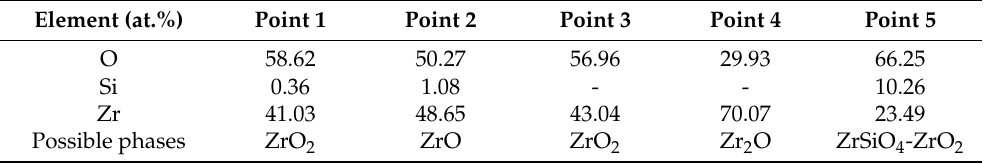
Table 5. EDS results at different parts of the cross section of the coating after oxidation. Element (at.%)